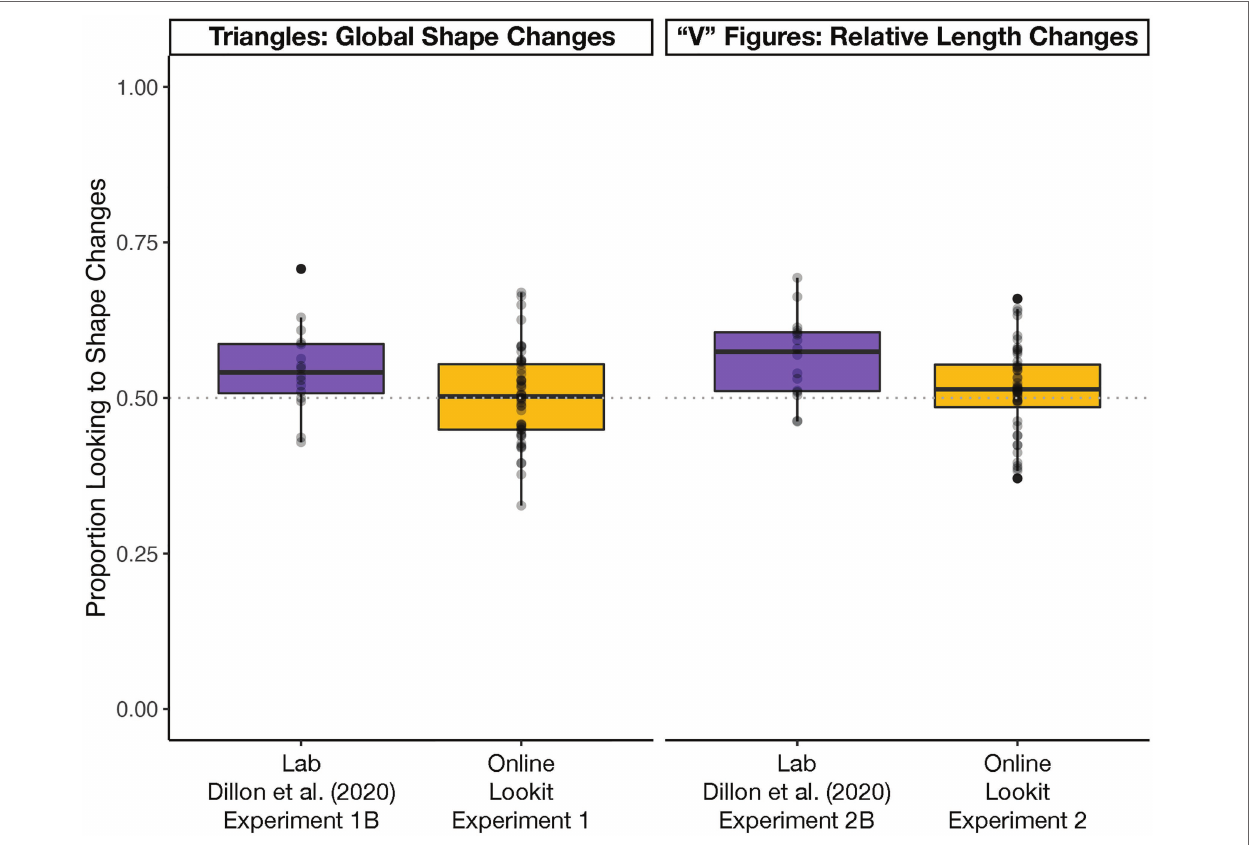
FIGURE 2 | Boxplots describing the proportions of infants’ looking to shape changes ( left ) and relative length changes ( right ) in laboratory experiments, reported in Dillon et al. (2020, N = 16 per experiment), and in the present online experiments ( N = 48 per experiment). They gray-dotted line at 0.50 indicates no looking preference, and the overlaid points display each participant’s individual preference, collapsed across an experiment’s four blocks. While infants looked longer at shape changes in the laboratory experiments, they did not look longer at shape changes in the online